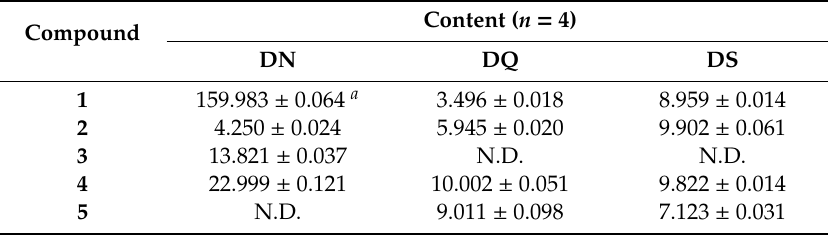
Table 4. Content of compounds in the three di ff erent samples (mg /